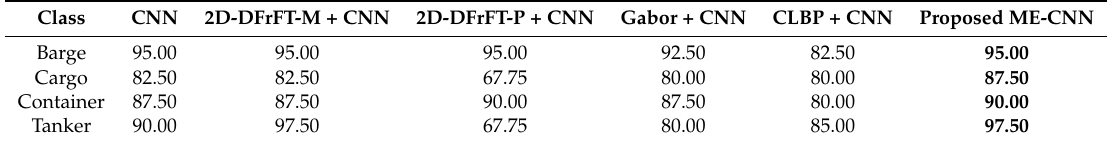
Table 9. Class-specific accuracy (%) for the original BCCT200 data.